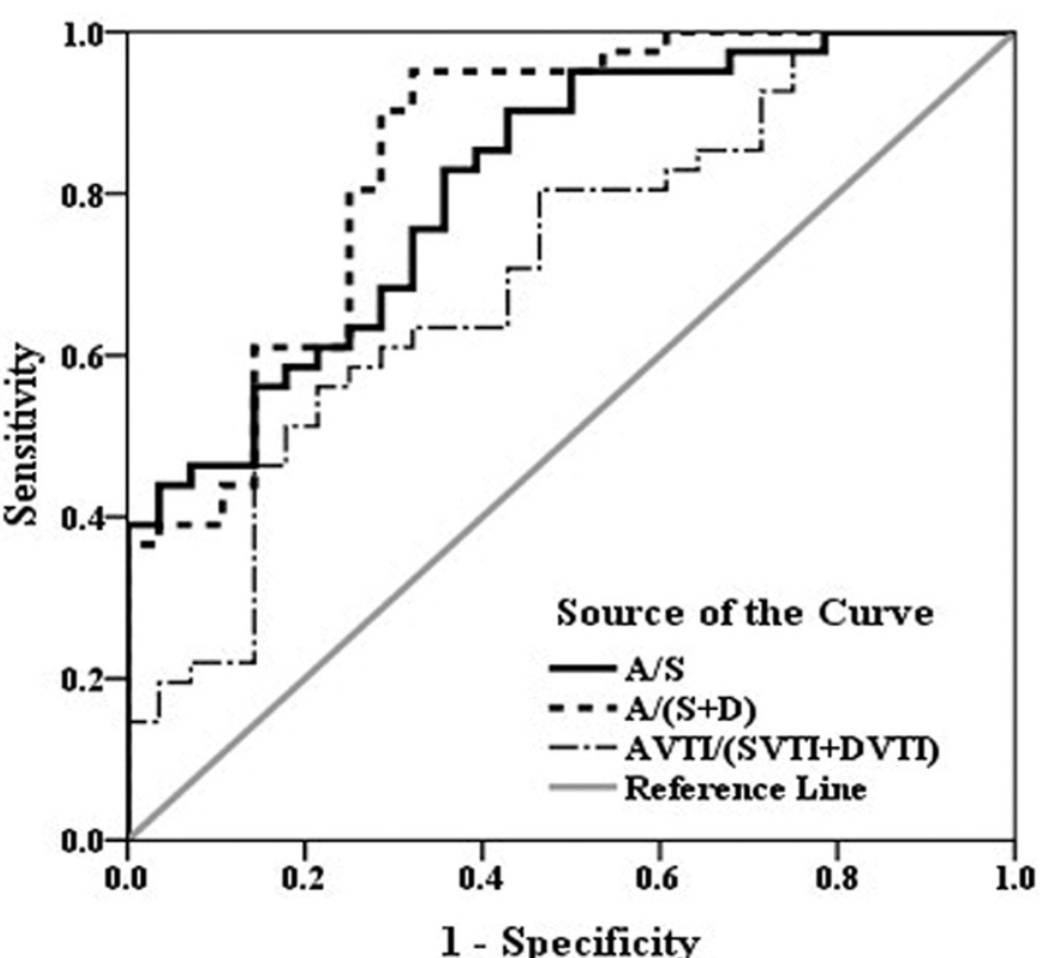
Fig 6. ROC curve of A/S, A/(S+D) and AVTI/(SVTI+DVTI) for predicting PH (MPAP (cid:1) 25 mmHg). The diagnostic effect of the A/(S+D) radio is superior to the other three parameters. On the ROC curve of A/(S+D), the point that has the biggest Youden index is determined to be the cut-off point (0.30 with a sensitivity of 85.37% and specificity of 75.00%). (SVTI, systolic flow velocity time integral; DVTI, diastolic flow velocity time integral; AVTI, atrial reverse flow velocity time